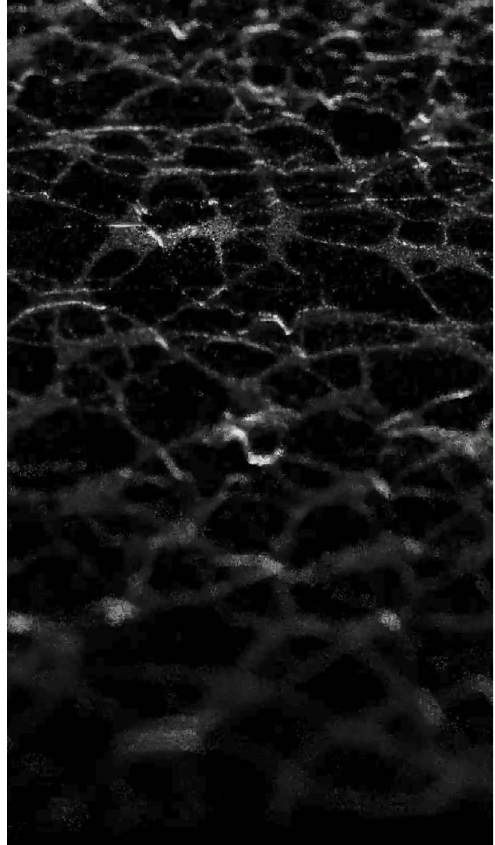
Figure 6: A parameterization of the Physarum polycephalum simulation results in what visually resembles neuron-like structures. The use of this visual substrate as a starting point for Feed enables fluid iteration on a work that synthesizes multiple systems in one representation. By adapting the representation over time, the composer can address the epistemological tensions that arise early in the process. Balance is achieved over time, and supports not only the aesthetic sensibilities and performance capacities, but the demand of accurate representation in relevant aspects of the